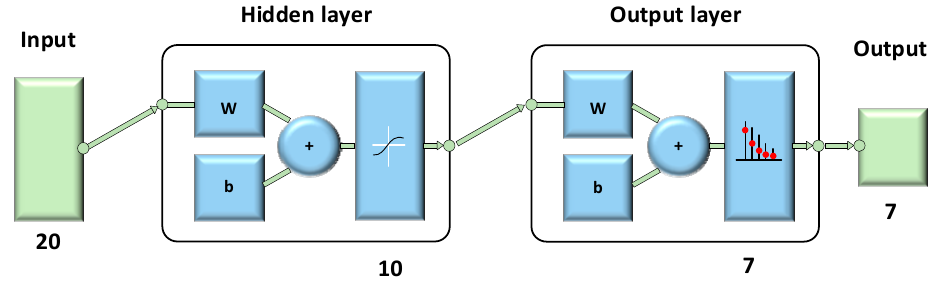
Figure 6. Diagram of the neural network.